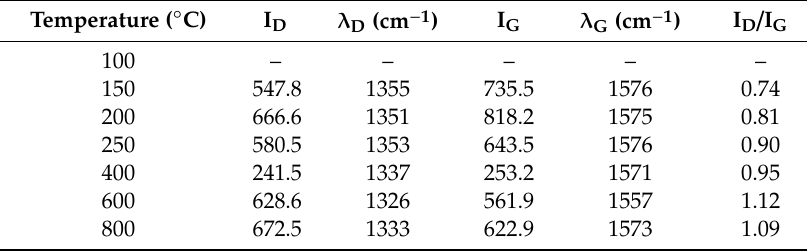
Table 3. Intensity ratios of D-band to G-band (I D / I G ) and Raman shifts of the samples’ bands